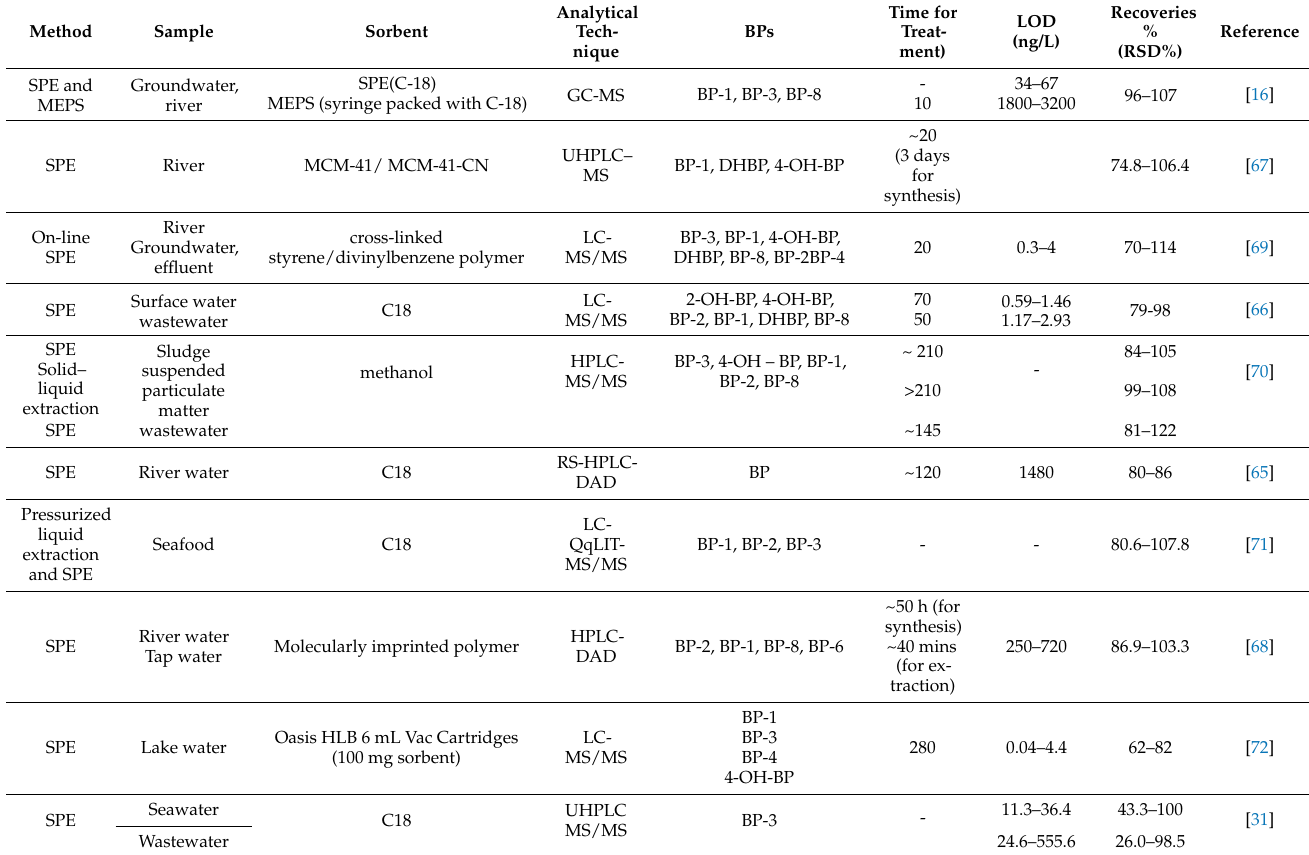
Table 2. Sample preparation methods based on SPE procedures for BP